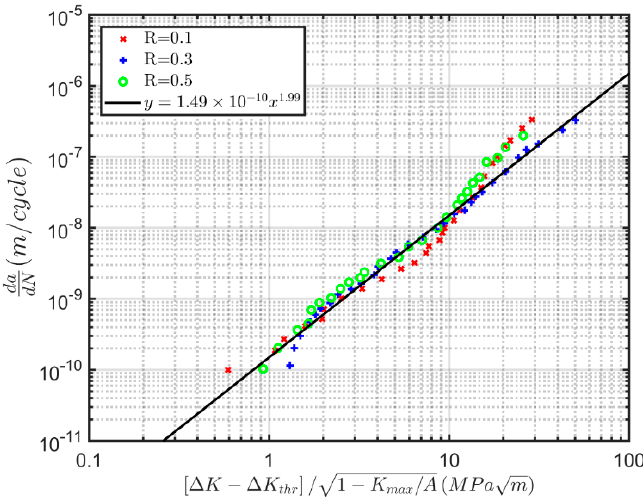
for (cid:1844) = 0.1, 0.3 and 0.5. Figure 7. Plot of da / dN versus ∆ K − ∆ K thr √ for R = 0.1, 0.3 and (cid:3493)(cid:2869) (cid:2879) (cid:3012) (cid:3288)(cid:3276)(cid:3299) /(cid:3002) 1 − K max / A